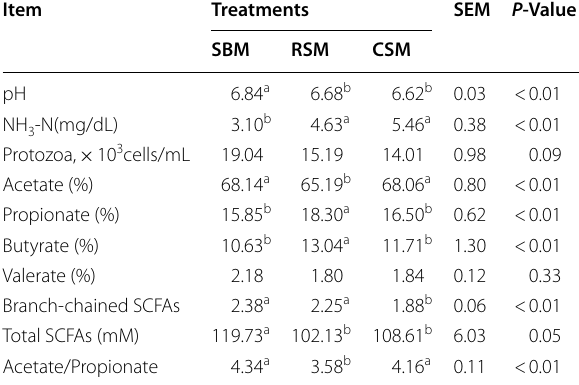
Table 3 Rumen fermentation parameters affected by different protein source of diets Fig. 1 The rarefaction curve of species. (C1-C6 indicated samples